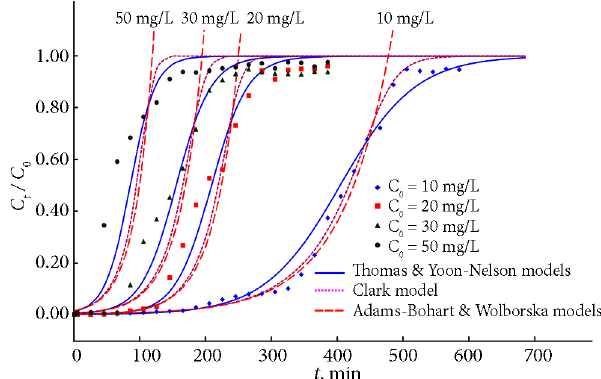
Figure 4. Effect of influent concentration on breakthrough curve for As(V) adsorption removal by the PC-Fe/C adsorbent prepared with eucalyptus wood template (flow rate: 5.136 mL/min; pH: 3; adsorbent mass: 2 g; adsorbent grain size: Figure 3. SEM result of the PC-Fe/C adsorbent prepared with <100 mesh; operating temperature: 35 ° C) eucalyptus wood biotemplate